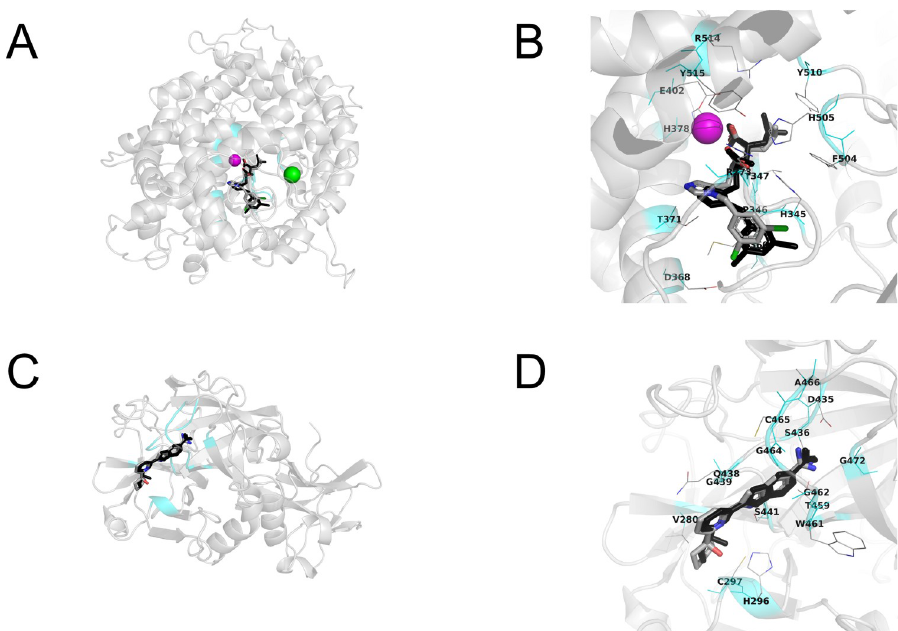
Fig 5. Re-docking studies for human ACE2 and human TMPRSS2 model with their crystal inhibitors. (A, B) Human ACE2. (C, D) Human TMPRSS2 model. The most stable docking mode of crystal inhibitor shows in CPK color using tubes. The original crystal structure of the inhibitor is represented by black tubes. A magenta sphere shows Zn 2+ ion and a green sphere shows the Cl − ion. The inhibitor-binding site located at 3 Å from all heavy atoms of the crystal inhibitor is shown in cyan color. Amino acid residues located at 3 Å from the inhibitor are shown using thin tubes with label. Hydrogen atoms are neglected.